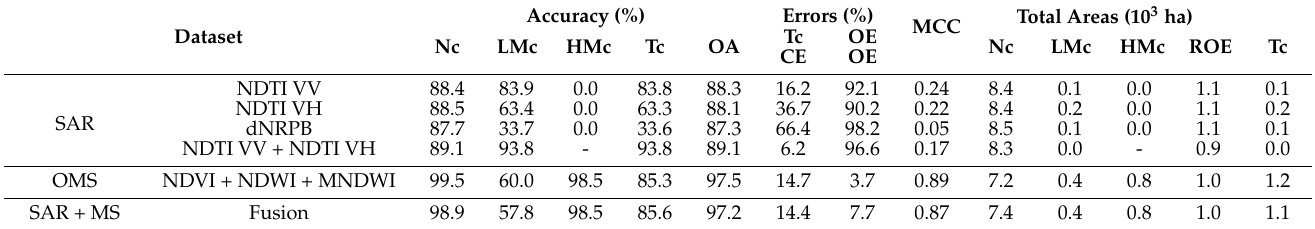
Table 10. Summary of the confusion matrix parameters and Matthews Correlation Coefficient (MCC) obtained for the Monte Pisano fire, in comparison to the Reference Observed Event (ROE) (Nc—no changes; LMc—low-magnitude changes; HMc—high-magnitude changes; Tc—total changes;